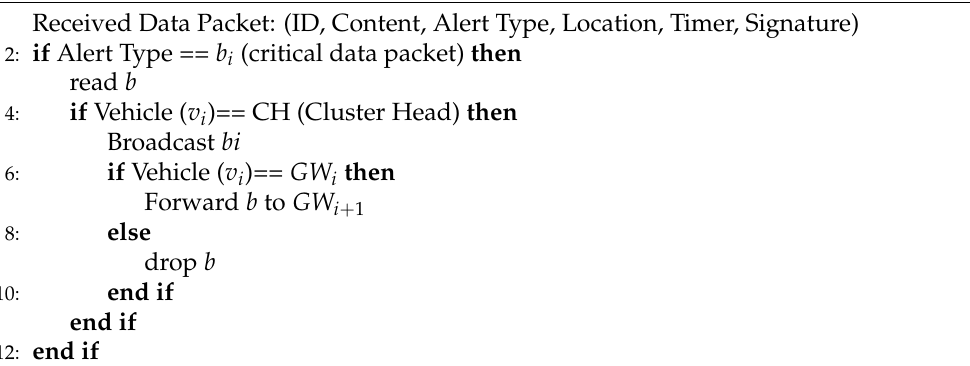
Algorithm 2 The proposed push-based critical data forwarding algorithm at a consumer.